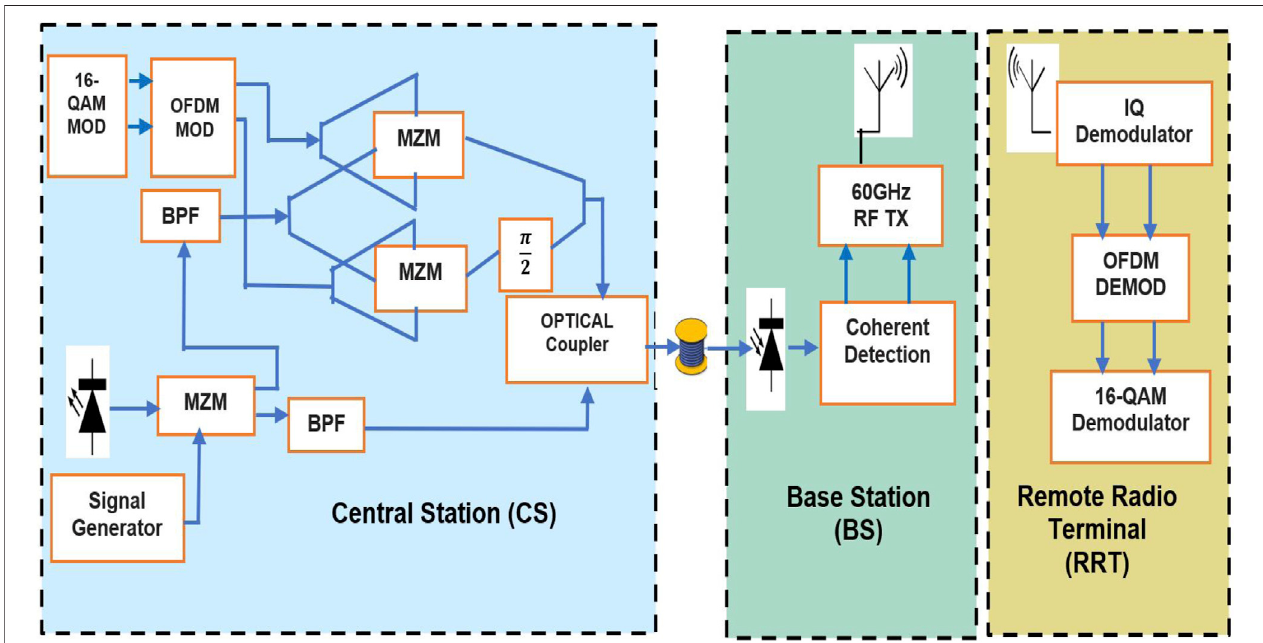
FIGURE 1 | Block diagram of the proposed 60 GHz radio-over- fi ber